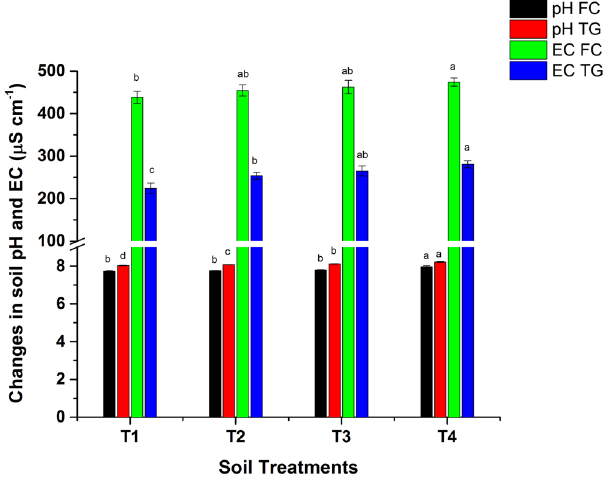
Figure 1. Effect of bamboo biochar amendments on soil pH and EC in Feng county and Tongguan soil. The data represent the mean of three replicates, and the error bars are standard deviations. Means with different letters are significantly different ( p < 0.05). (T1 = Control, T2 = 1.0% BB, T3 = 2.5% BB, T4 = 5.0% BB).